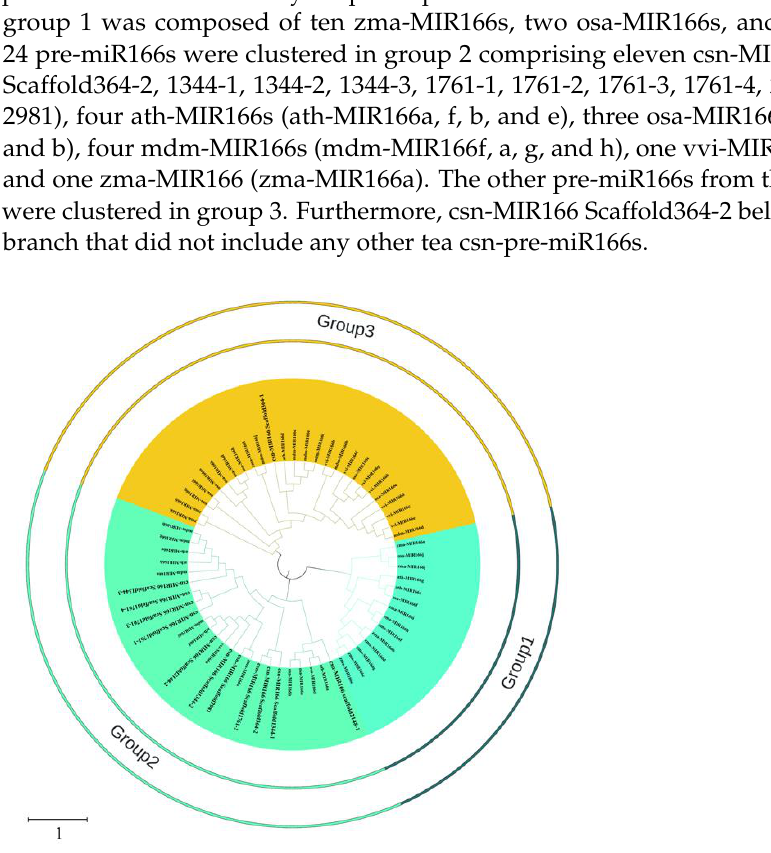
Figure 4. Phylogenetic relationships of pre-miR166 sequences in plants. vvi. Vitis vinifera L.; mdm. Malus domestica B.; osa. Oryza sativa L.; csn. Camellia sinensis (L.) O. Kuntze; ath. Arabidopsis thaliana (L.) Heynh; zma. Zea ma y L.